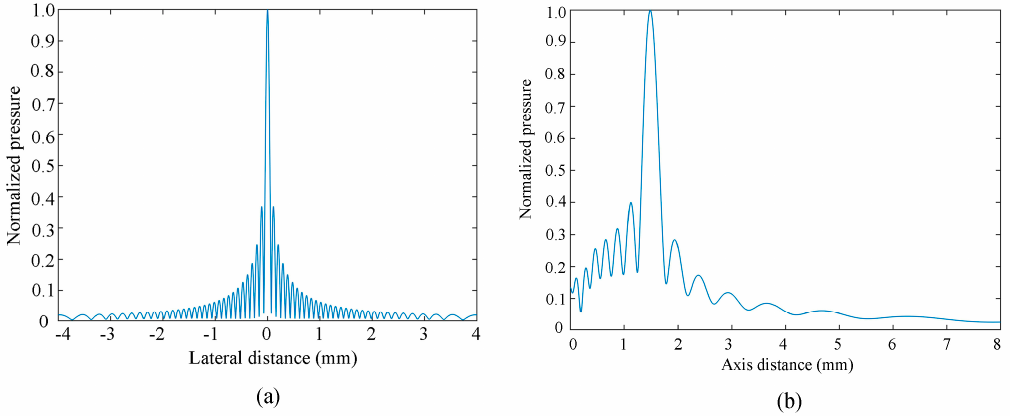
Figure 2. The lateral sound field ( a ) and axis sound field distribution ( b ).